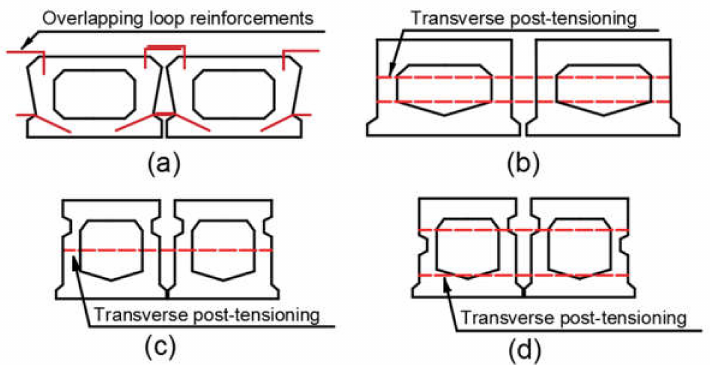
Figure 1. Comparison of adjacent beams with different transverse connections [2]: ( a ) China, ( b ) Japan, ( c ) the United States, ( d ) South